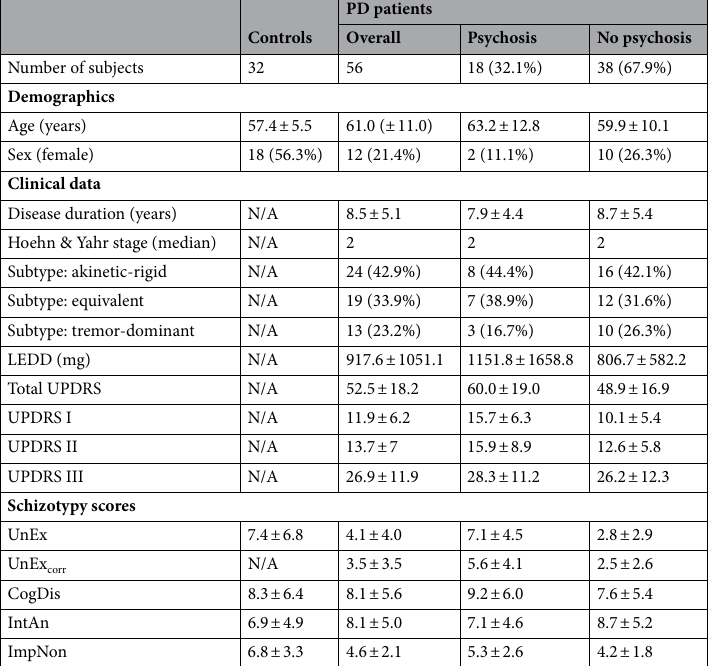
(Table 1). We chose this study design in order to avoid selection bias by matching parameters, e.g. as could occur in a case–control study, and possible over-matching and therefore enable a fully data-driven, multifactorial pre- diction of psychosis. We excluded patients with other relevant neurological and psychiatric diseases including dementia and depression. In order to maximize external validity of our results, we did not otherwise restrict the patient population to particular subject characteristics or disease-related factors. We did not screen patients or controls for family history of psychiatric disorders.